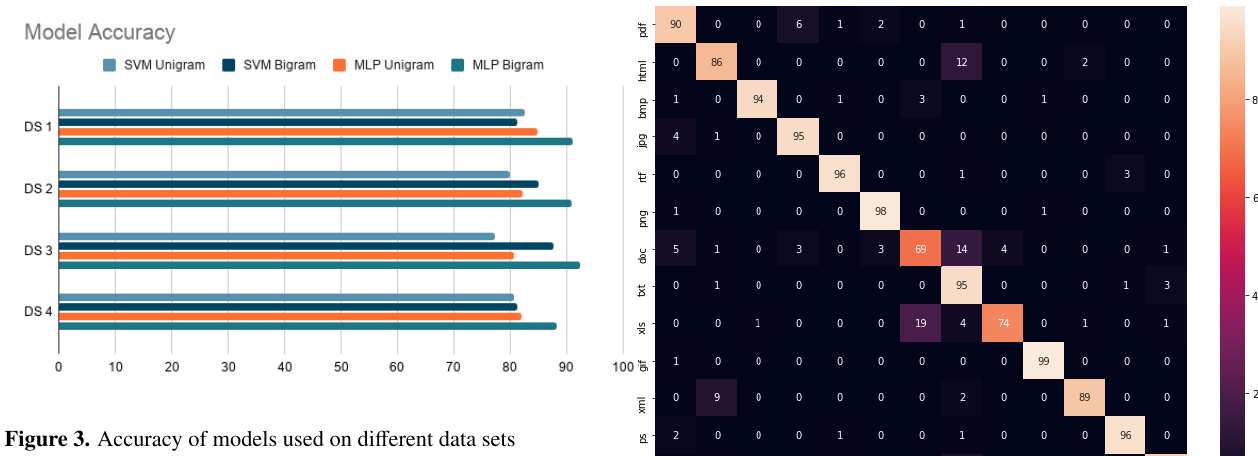
Figure 3. Accuracy of models used on di ff erent data sets